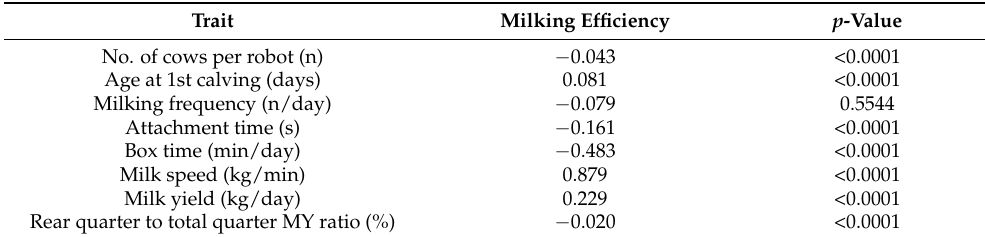
Table 4. Pearson’s linear correlation between milking efficiency and number of cows per one